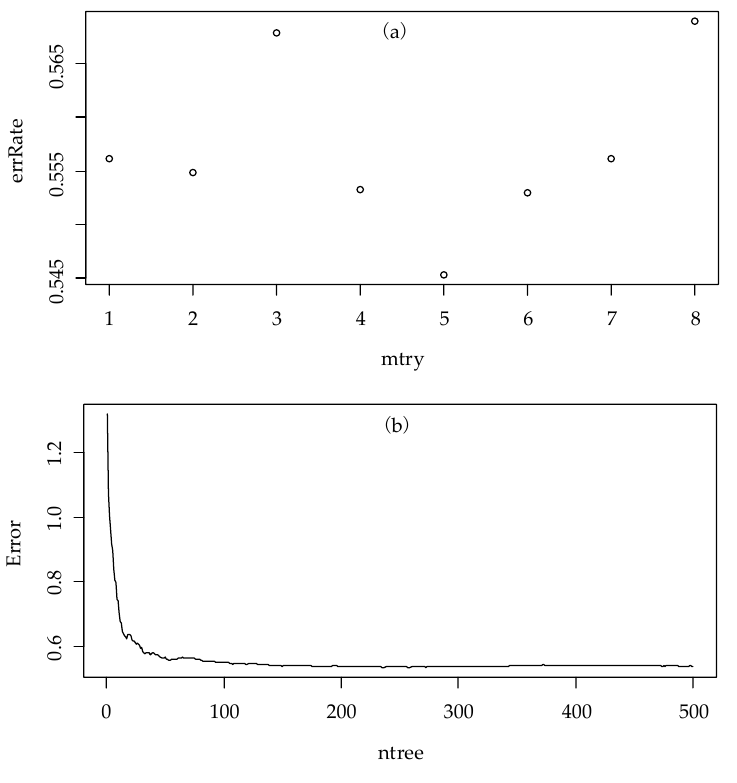
Figure 6. ( a ) Distribution of the error rates versus mtry, and the best mtry was 5. ( b ) Distribution of error versus the number of trees, and the best ntree was 257. the error versus the number of trees, and the best ntree was 257.